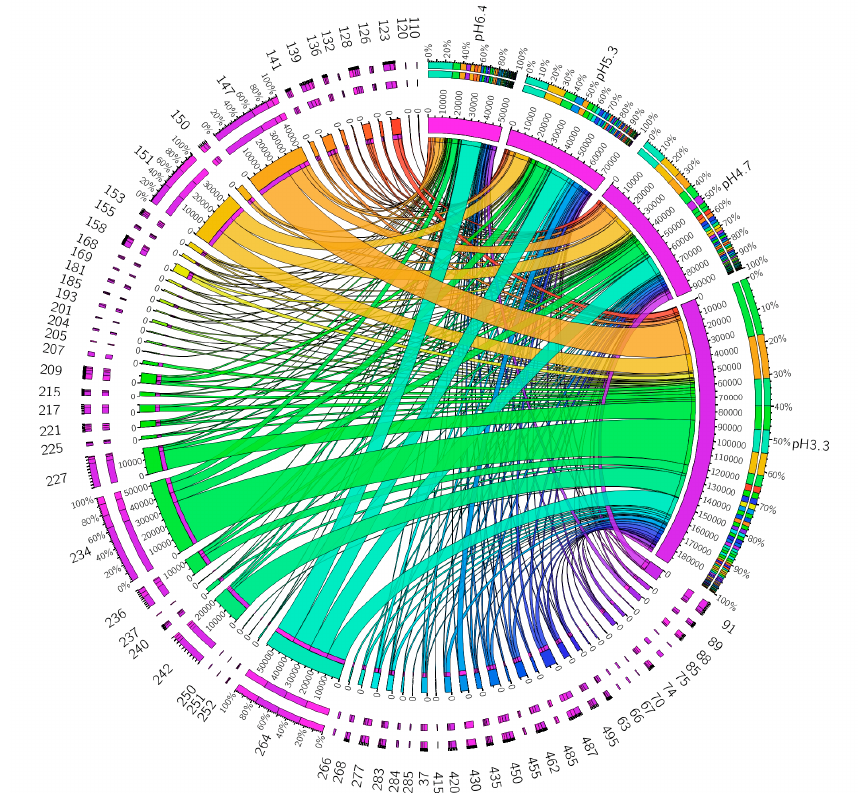
Fig. 1: The Circos plot representing the changes of T-RFs fragments of fungi in rhizosphere soil of tea trees at different soil pH